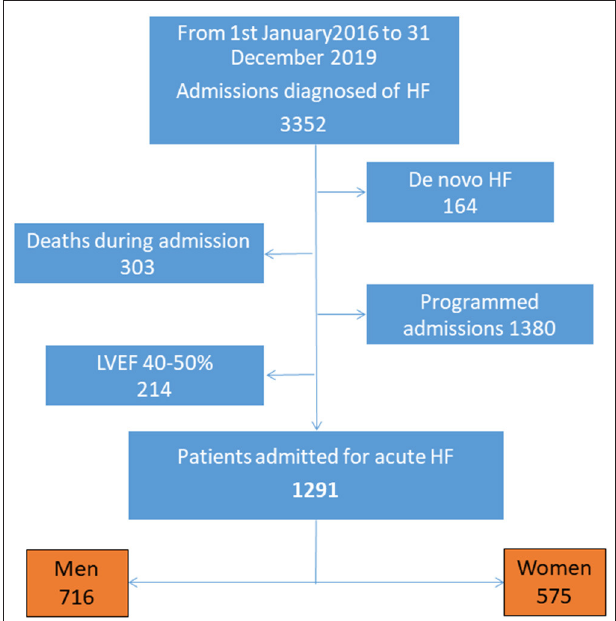
FIGURE 1 | Study flow-chart. HF, Heart failure; LVEF, Left ventricular eyection